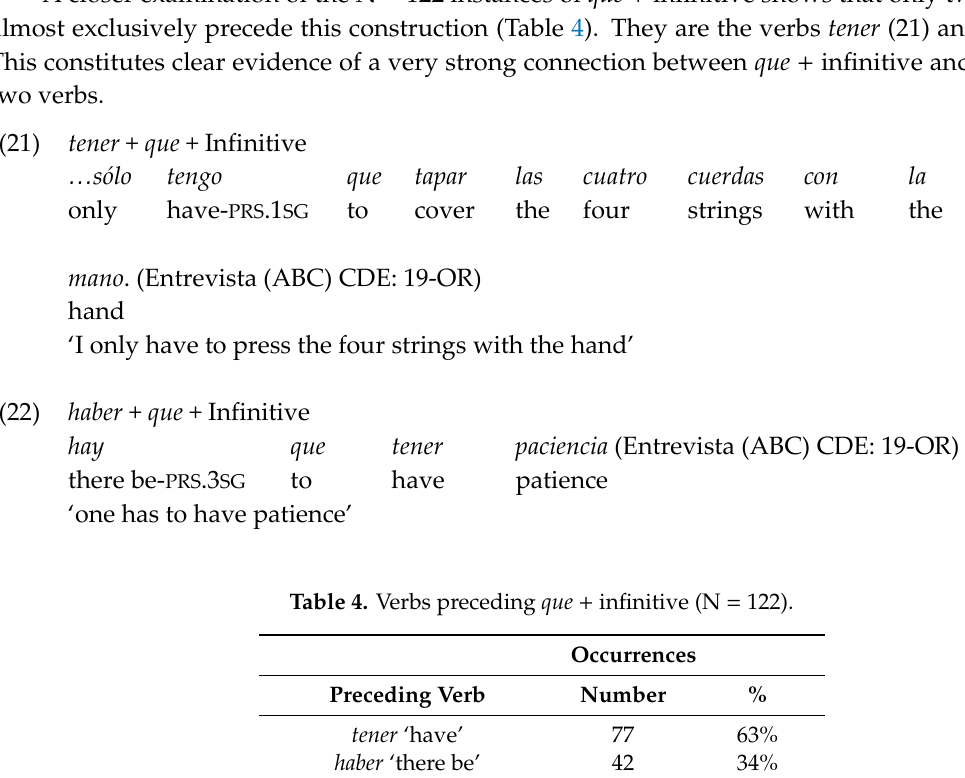
Table 4. Verbs preceding que + infinitive (N = 122).